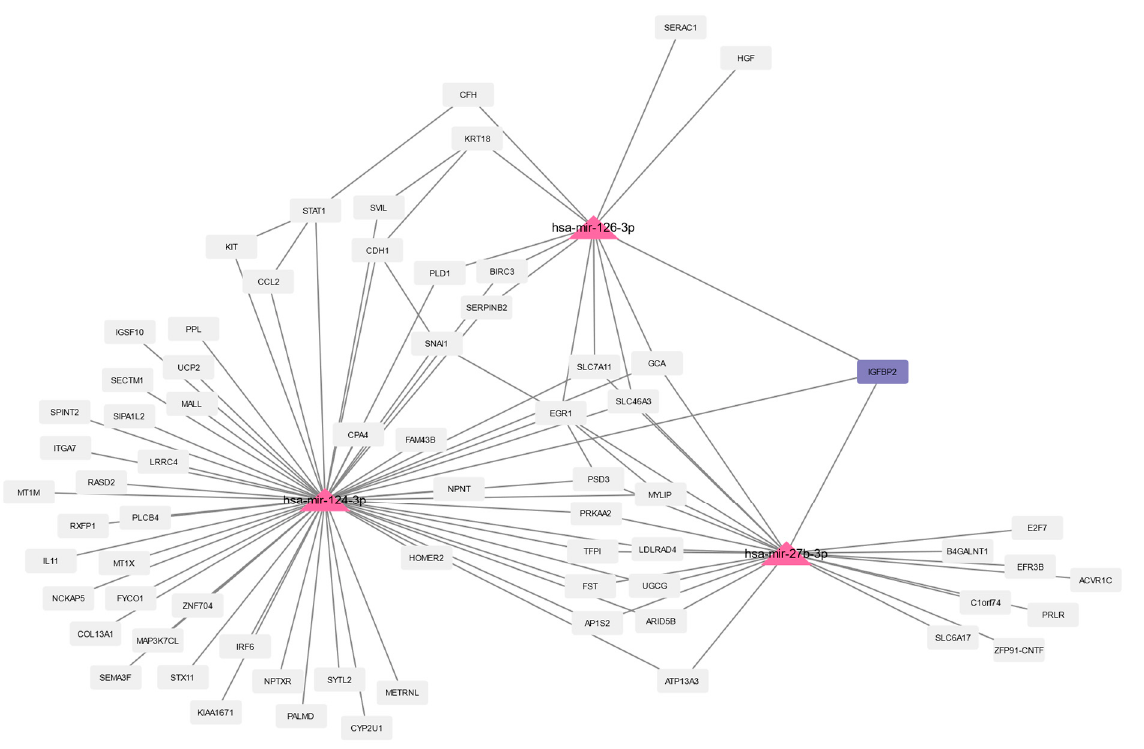
Figure 8. miRNA prediction and network visualization of miRNAs related to IGFBP2. Predicted miRNA interaction partners of hsa-mir-124-3p, hsa-mir-126-3p, and hsa-mir-27b-3p, IGFBP2 is high- lighted.